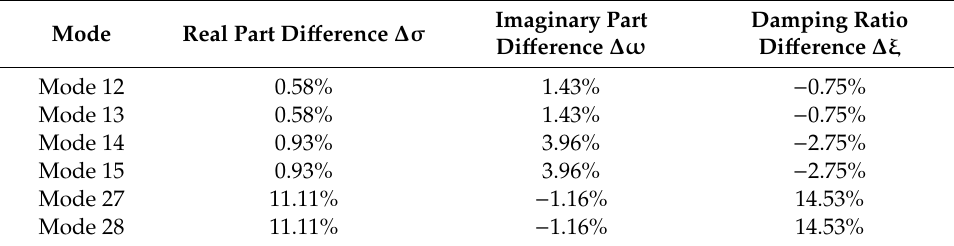
Table 9. Oscillatory modes, operating point 2, di ff erence SVC connected /